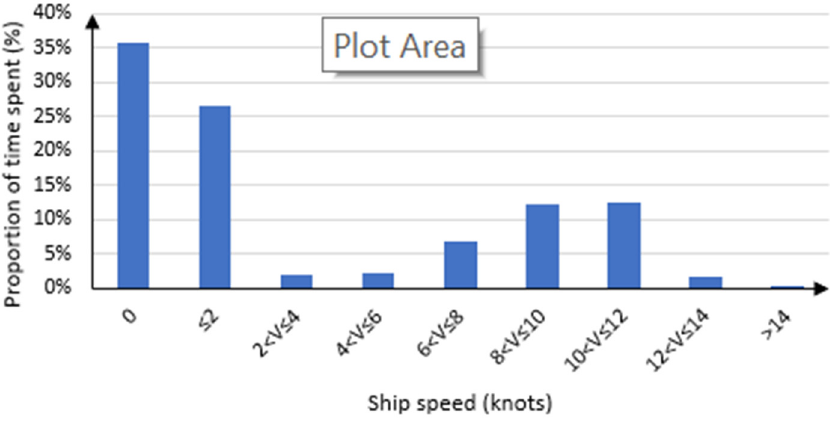
Figure 7. Speed distribution with time for MPSV.